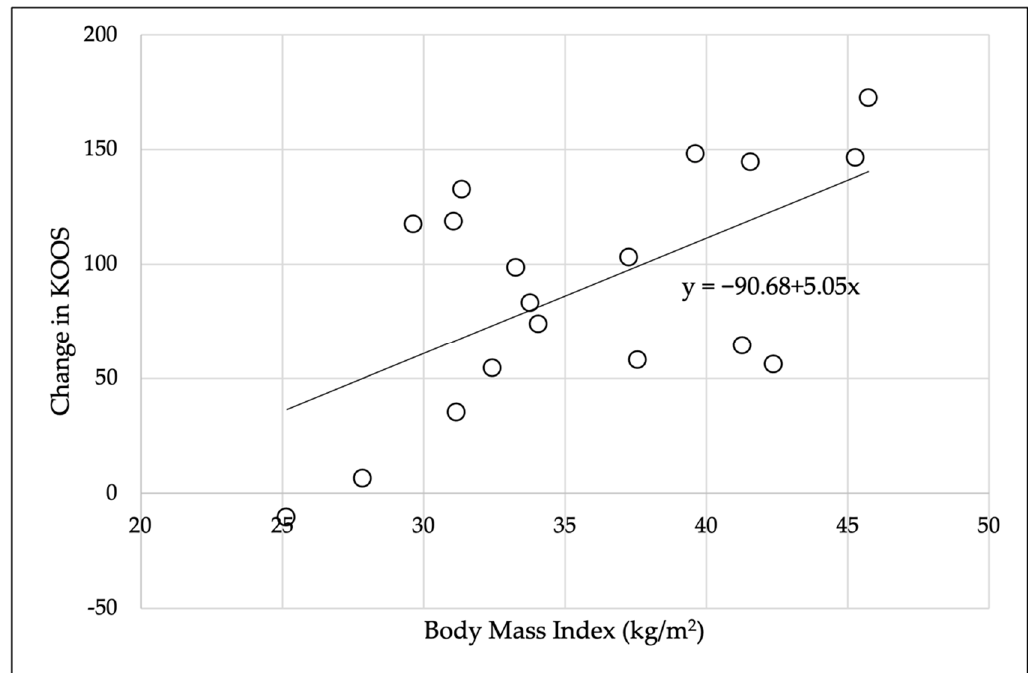
Figure 3. Relationship between body mass index and change in KOOS.